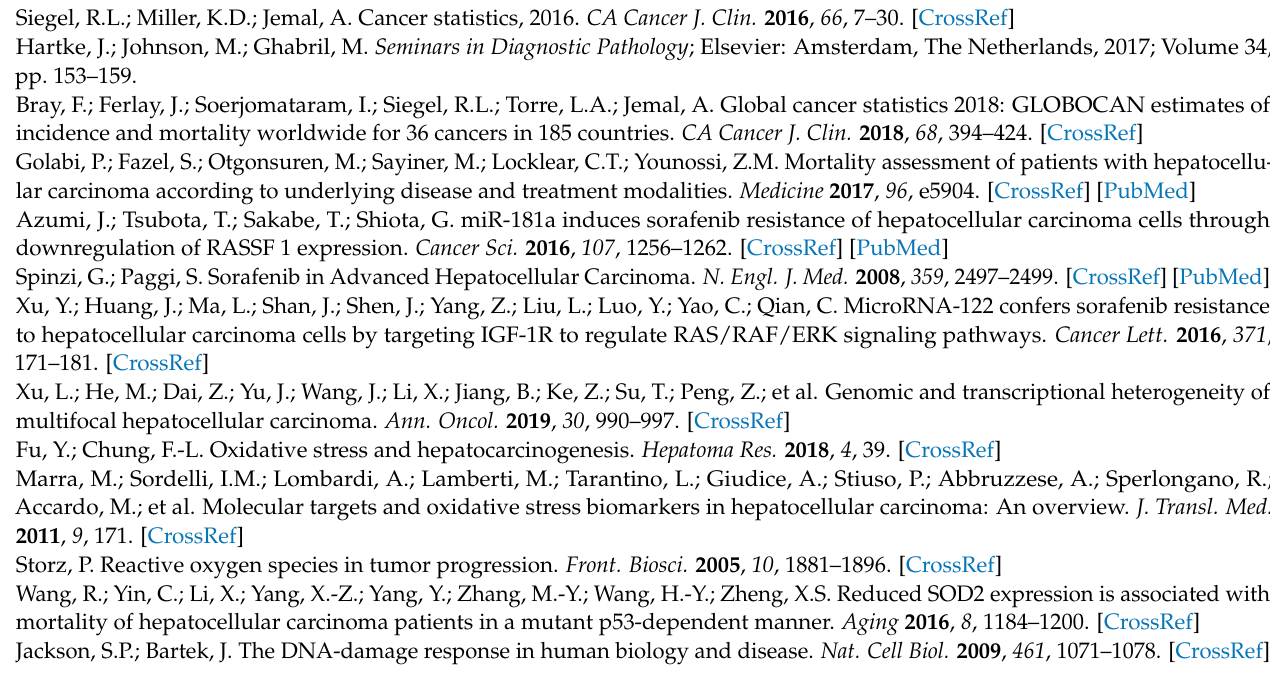
blot raw data: Figure S1. Full-size blots of Figure 3D. Figure S2. Full-size blots of Figure 4D. Figure S3. Full-size blots of Figure 5D. Figure S4. Full-size blots of Figure 6D. Figure S5. Full-size blots of Figure 7E. Figure S6. Full-size blots of Figure 8F. Figure S7. Full-size blots of Figure